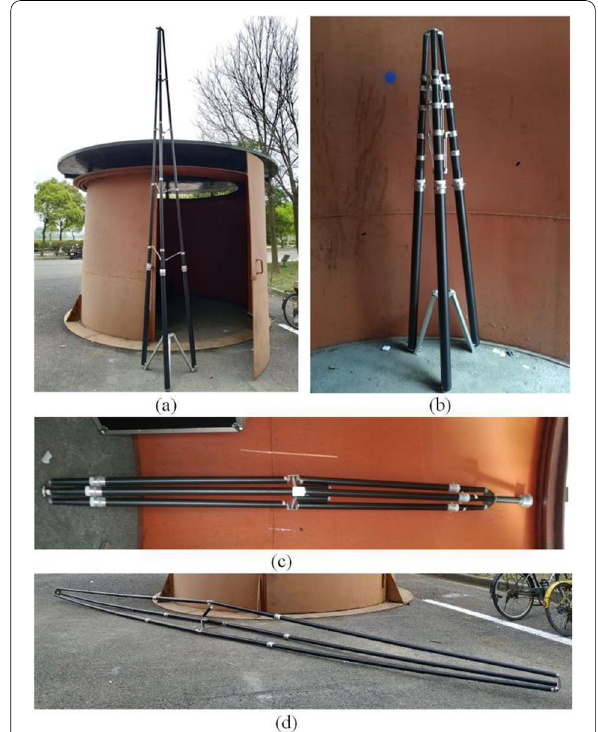
Figure 14 Prototype of the column and cantilever: a Unfolding column; b Folding column; c Unfolding cantilever; d Folding